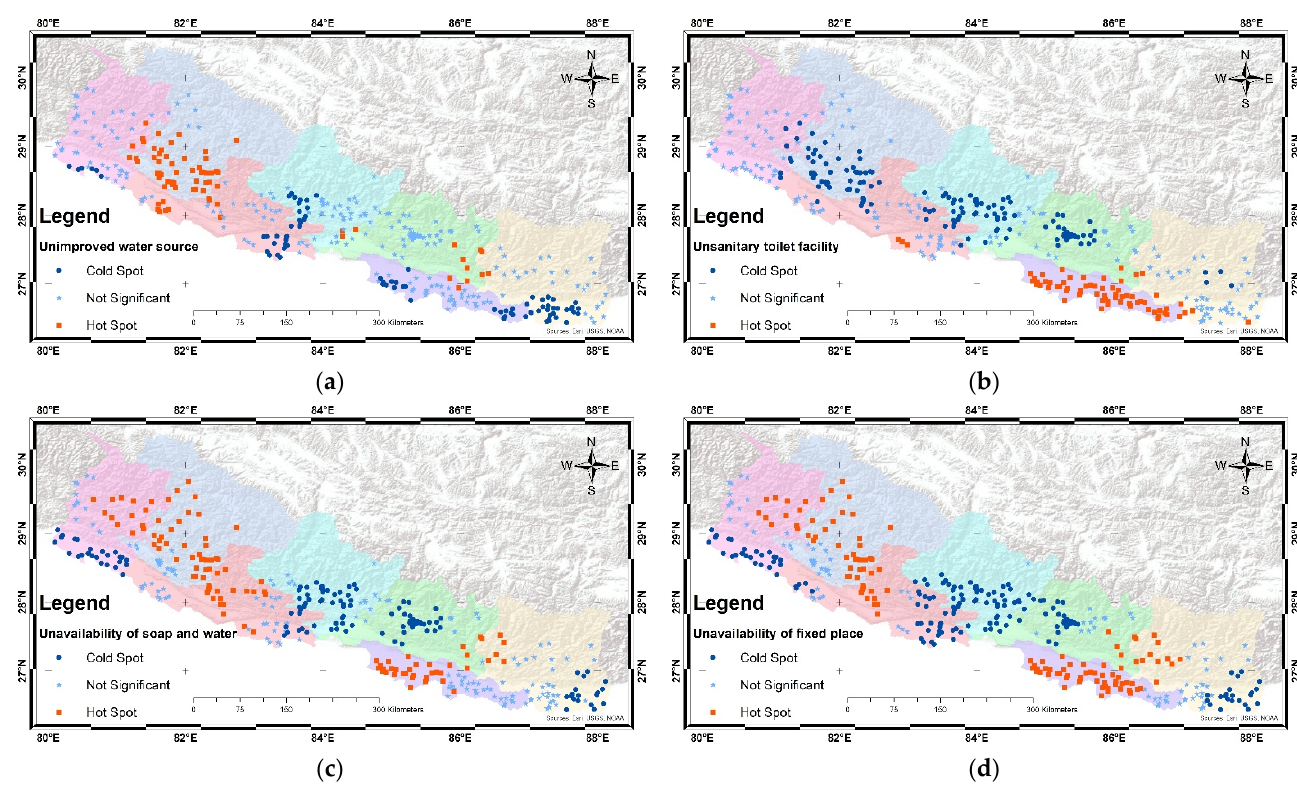
Figure 2. Mapping cluster in Nepal: ( a ) unimproved water source; ( b ) unimproved sanitation; ( c ) unavailability of soap and water; and ( d ) unavailability of a fixed place.